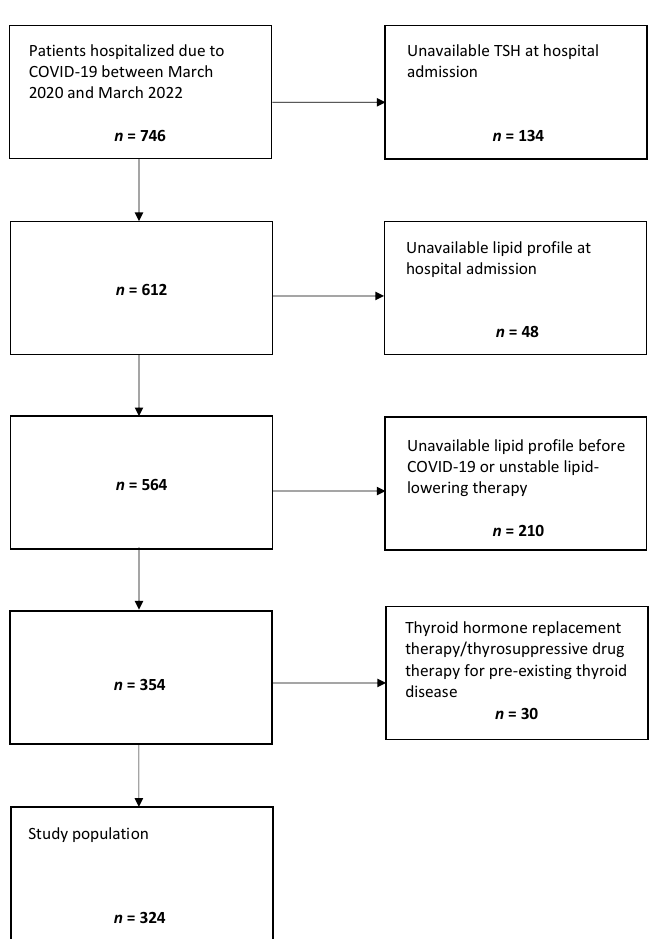
Figure 1. Selection of the study population.